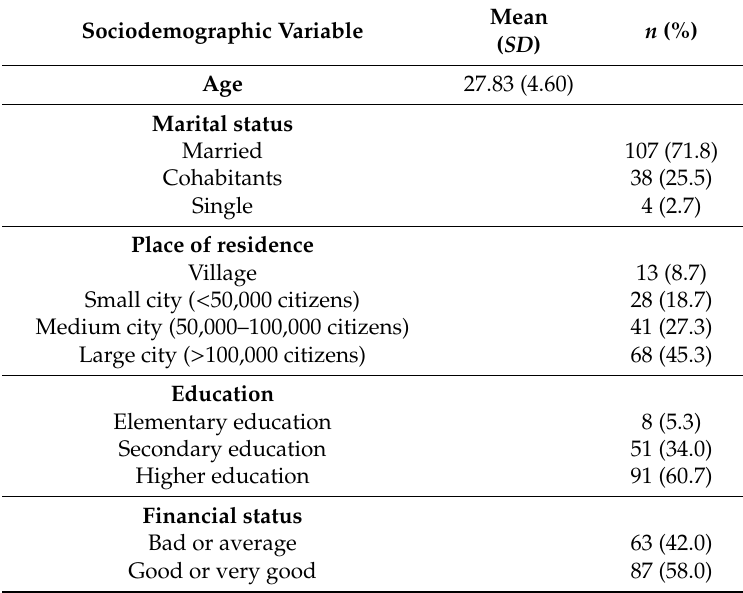
Table 1. Sociodemographic characteristics of pregnant women ( N =